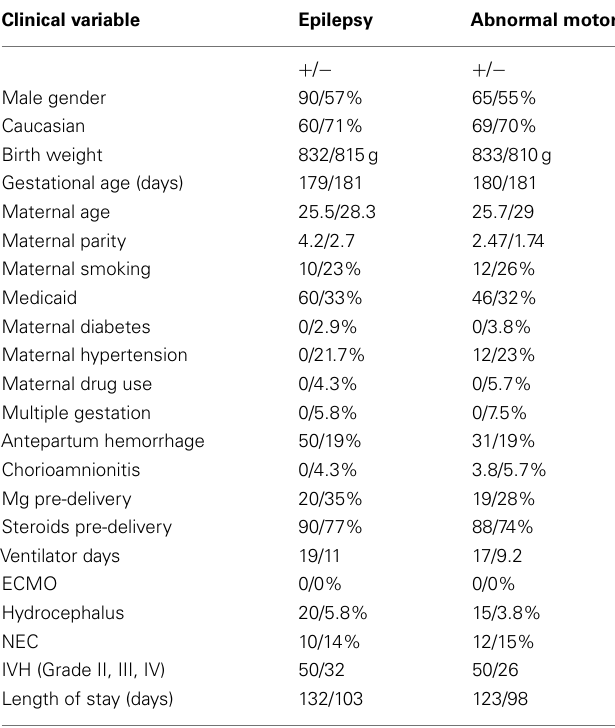
Table 6 | Comparison of clinical variables in “low” and “high” magnesium patient groups .